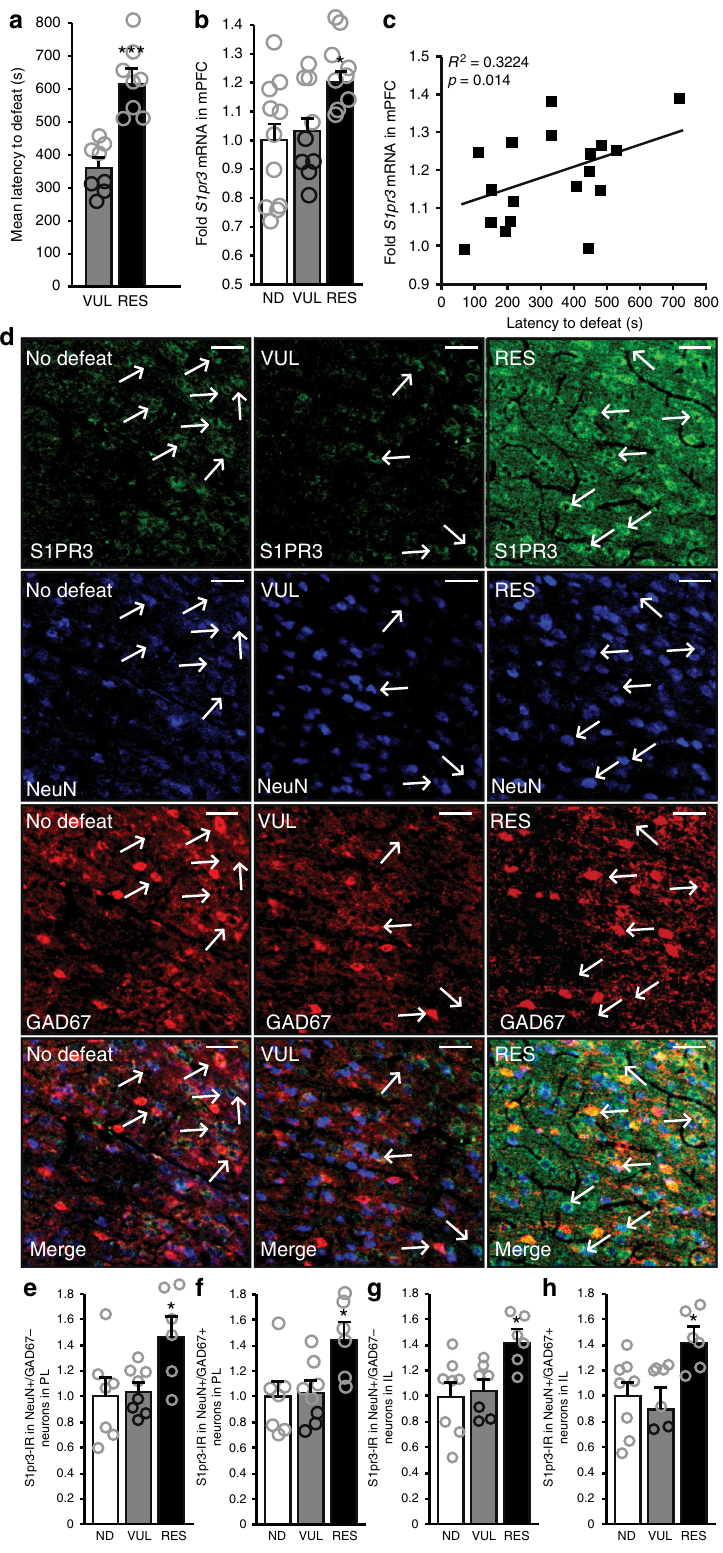
Fig. 2c). S1PR3 overexpression did not alter behavioral pheno- types in ND rats (Fig. 2n, o), though it modestly reduced ACTH response to the novel stress of restraint (Fig. 2p). This may indicate that, with suf fi ciently high expression, S1PR3s are important in limiting HPA responses to acute